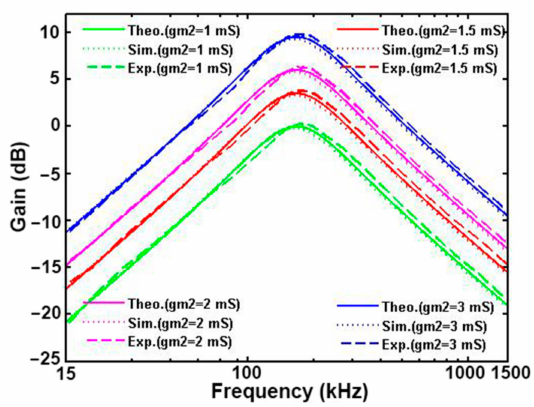
Figure 6. The theoretical, simulated and measured NBPF responses at the voltage output of V BP2 when g m2 was varied.